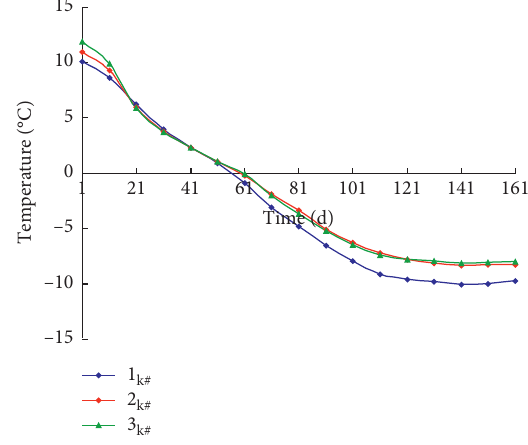
Figure 13: Measured temperature.